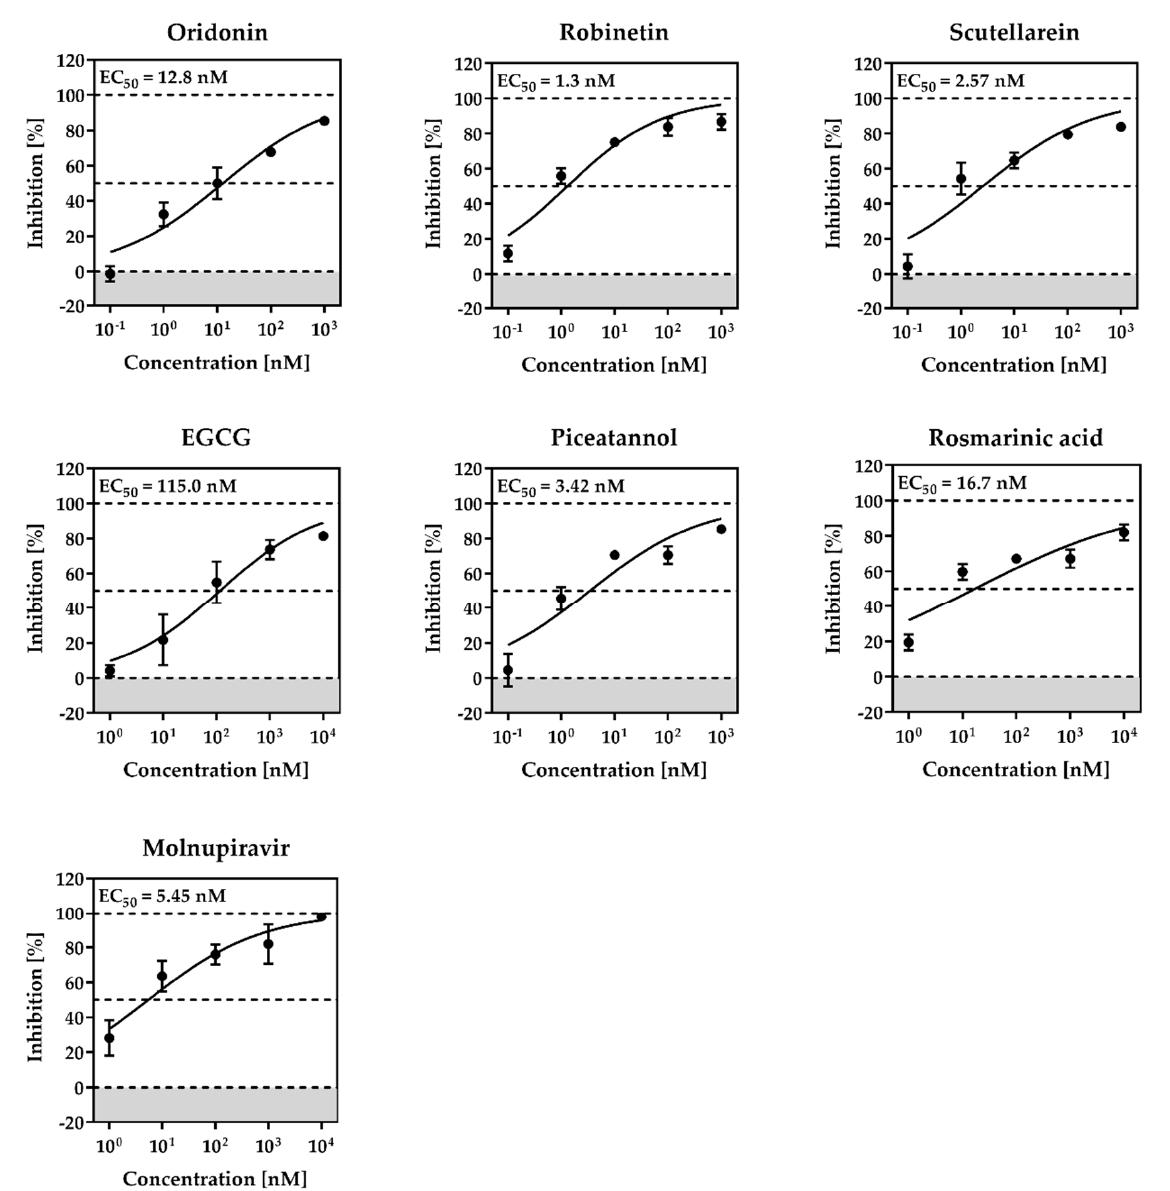
Figure 9. Antiviral activity and cytotoxicity of robinetin, piceatannol, rosmarinic acid, scutellarein, EGCG, oridonin in Calu-3 cells. Calu-3 cells were incubated with 10-fold serial dilutions (10 − 0.001 or 1-0.0001 µ M) of each inhibitor or DMSO (solvent control) for 1 h followed by infection with SARS-CoV-2 at a multiplicity of infection (MOI) of 0.01. After virus inoculation, cells were further incubated with the respective inhibitors for 24 h. Supernatants were harvested, and viral titers were determined by titration on Vero E6 cells. For normalization, viral titers of DMSO-treated cells were set as 0% inhibition. Means ± SDs from three biological replicates are presented.